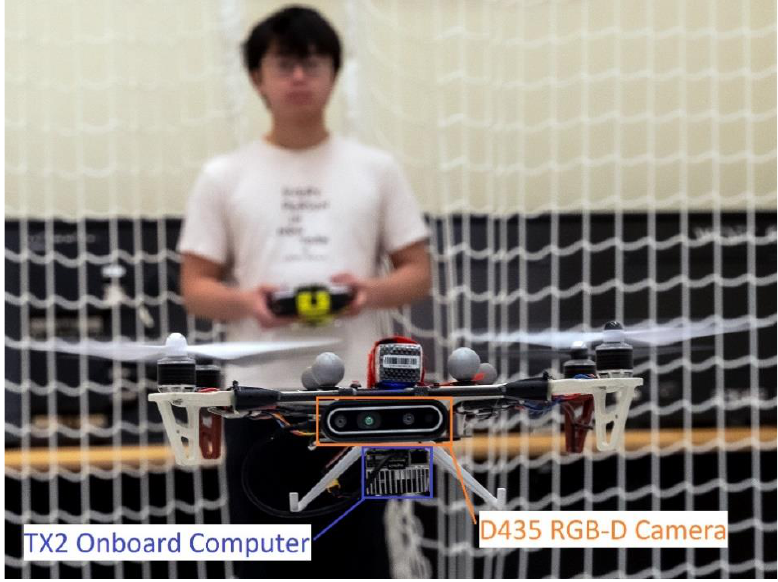
Figure 1. Prototype of proposed autonomous object tracking system.